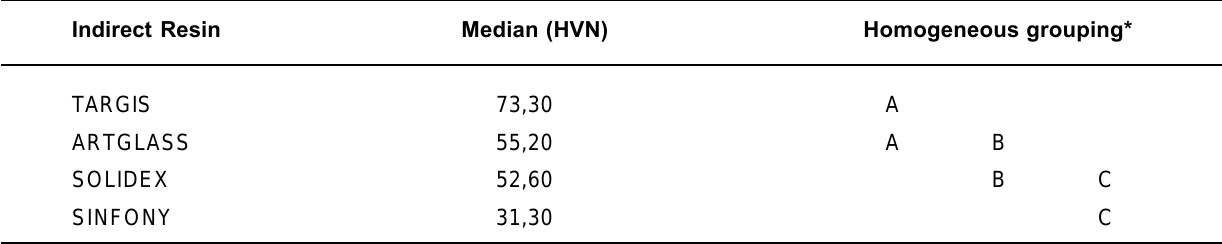
TABLE 2 - Homogeneous grouping and median microhardness values of indirect composite resins (Dunn Multiple Comparison Test -